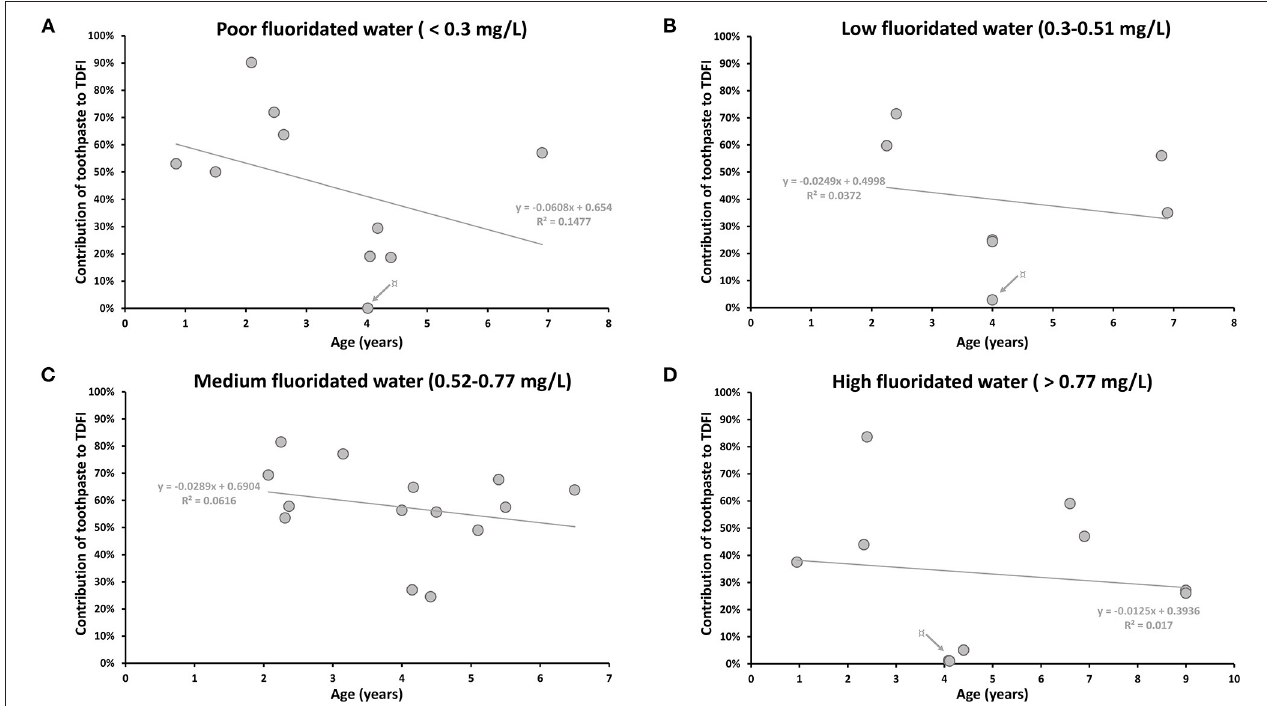
FIGURE 3 | The contribution of daily toothpaste intake according to mean age (years) of participants in areas with different F concentration in drinking water (mg/L). (A) The contribution of toothpaste to the TDFI (%) in poor fluoridated water ( < 0.3 mg/L). ¤ Gray arrow indicates the lowest value from Abuhaloob et al. [ 36]: two toothpaste users among 81 participants. (B) The contribution of toothpaste to the TDFI (%) in low fluoridated water (0.3–0.51 mg/L). ¤ Gray arrow indicates the lowest value from Zohoori and Rugg-Gunn [40]: 3 toothpaste users among 28 in Darab (not the same region presented in Figure 2 ; Table 3 ). (C) The contribution of toothpaste to the TDFI (%) in medium fluoridated water (0.52–0.77 mg/L). (D) The contribution of toothpaste to the TDFI (%) in high fluoridated water ( > 0.77 mg/L). ¤ Gray arrow indicates the lowest values from Abuhaloob et al. [36]: nine toothpaste users among 135